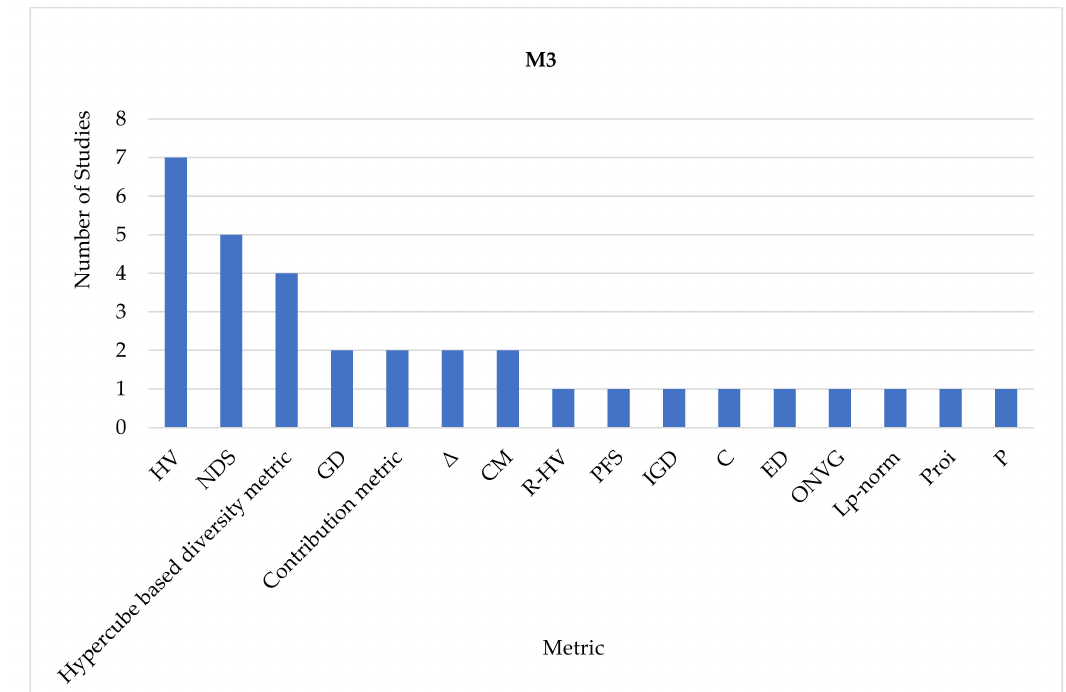
Figure 6. Metrics distribution in M3